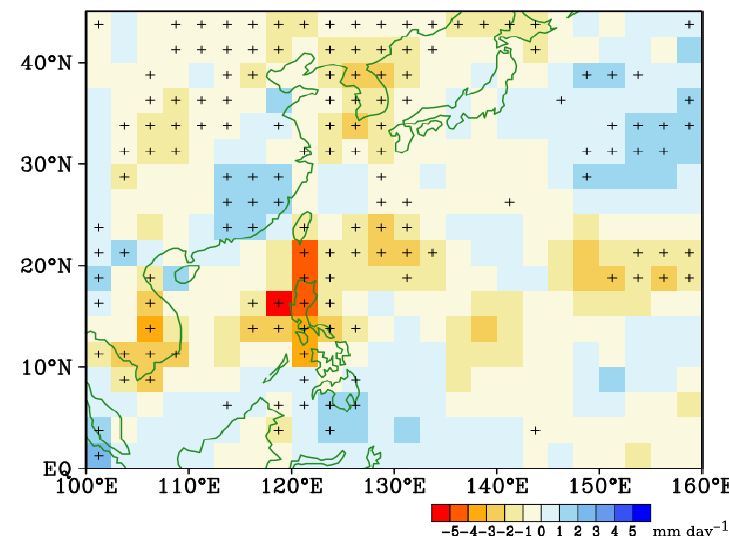
Figure 5. Epochal difference (E2 minus E1) in the spatially smoothed (1–2–1 filter; both longitudinal and latitudinal direction) CMAP rainfall (mm day − 1 ) during P45–P50. Cross (+) markings indicate statistical significance above the 90% confidence level.